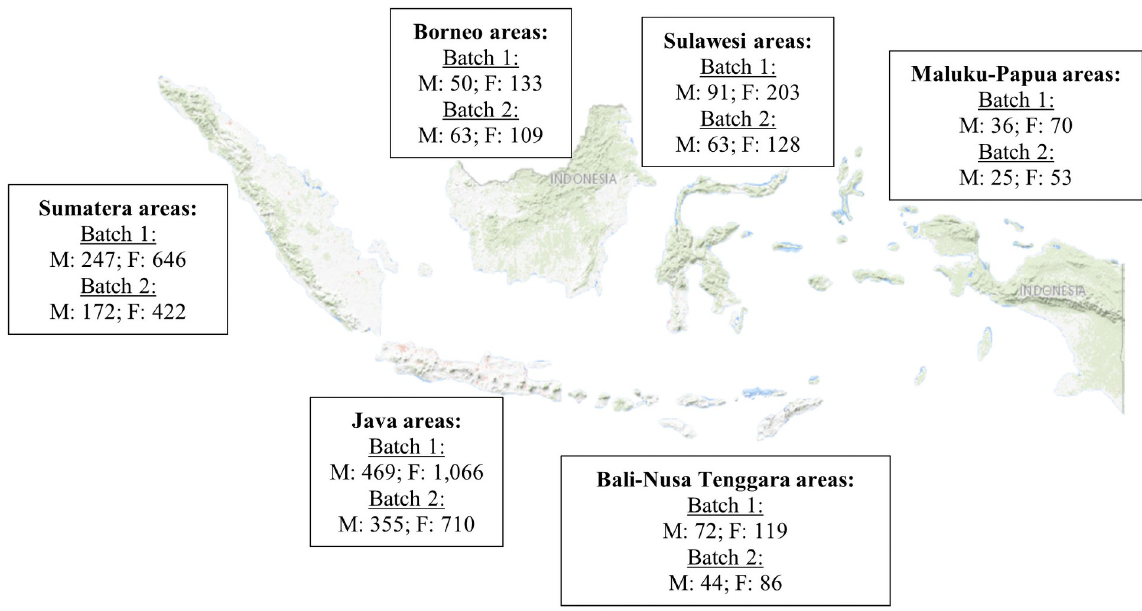
Fig 2. Characteristics of MTPC-I participants completing Part A from Batch 1 and 2 based on the internship area and gender (source of Indonesian map: https://apps.nationalmap.gov/viewer/).